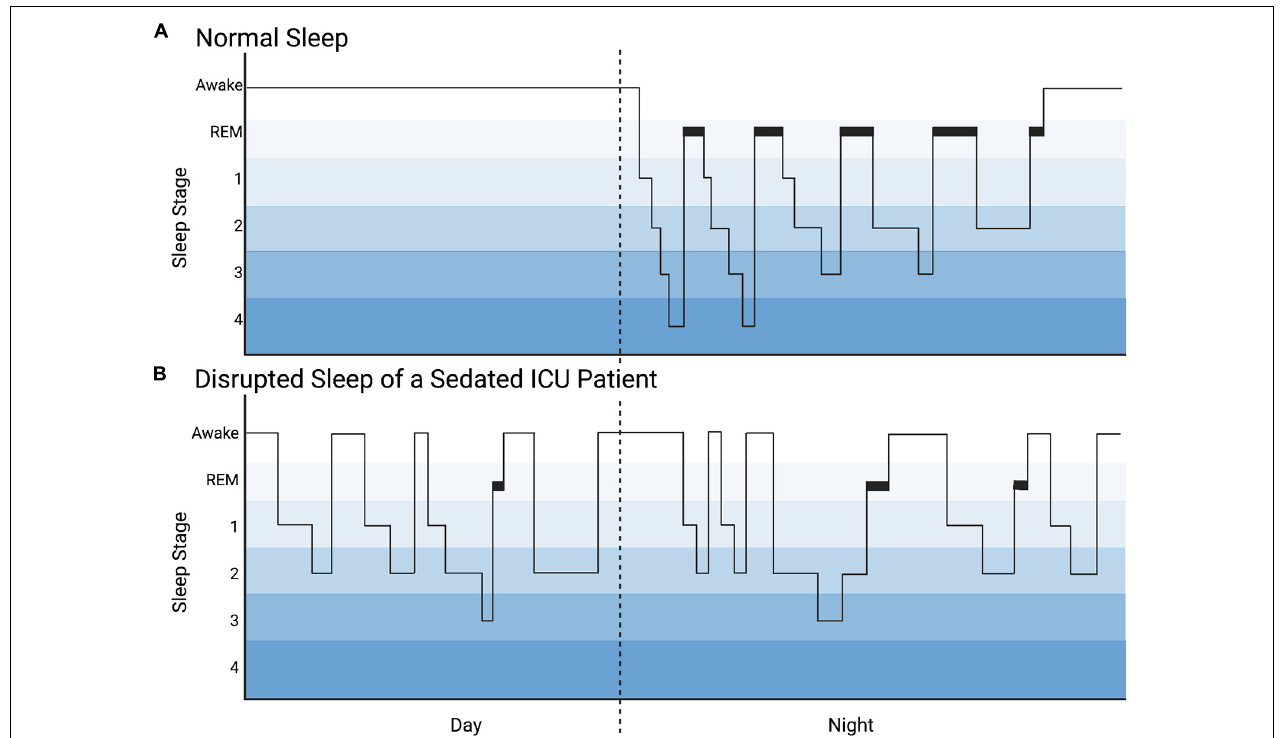
FIGURE 3 | Hyponogram of Normal Sleep and Disrupted Sleep of a Sedated ICU Patient. (A) The hyponogram of normal sleep depicts the cyclic progression through sleep stages: non-rapid eye movement [divided into light sleep (stages 1, 2) and deep slow wave sleep (stages 3, 4)] and rapid eye movement (REM) sleep. (B) The hyponogram of a sedated intensive care unit (ICU) patient is noted to have sleep distributed during the day and night and sleep fragmentation depicted by frequent awakenings. This patient has a predominance of light sleep (stages 1, 2) and decreased deep slow wave sleep (stages 3, 4) and REM